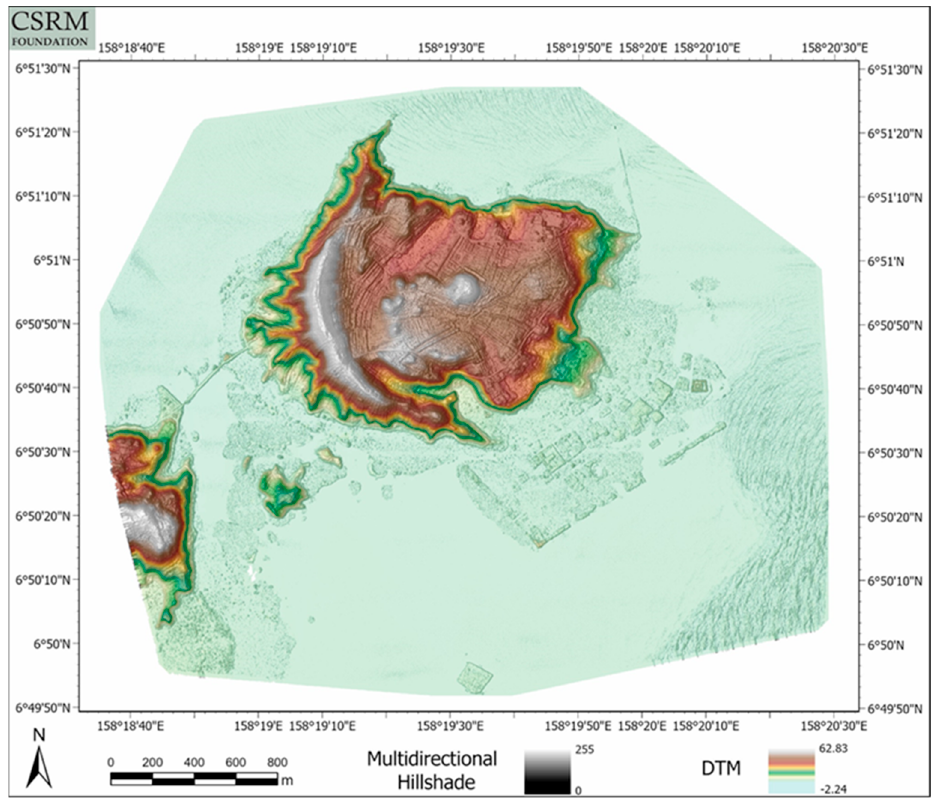
Figure 3. A colorized Digital Terrain Model (DTM) image overlaid on a multidirectional hillshade image.